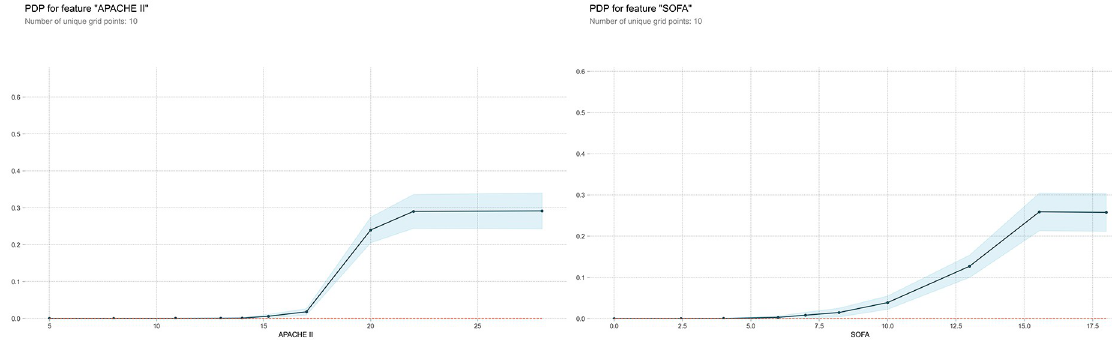
Fig 5. PDP for feature APACHE II (left) and SOFA (right).